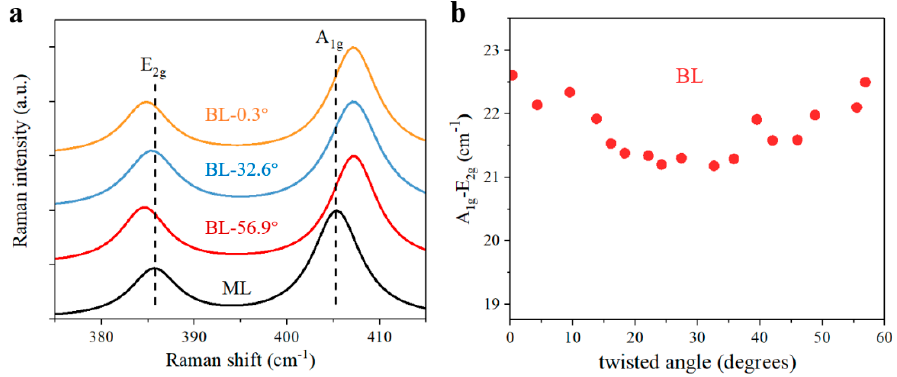
Figure 4. Raman spectra of twisted MoS 2 bilayers. ( a ) Raman signals of out-of-plane A 1 g and E 2 g in-plane vibration modes in prototypical monolayer and twisted bilayers. ML, monolayer. ( b ) Raman interval of A 1 g and E 2 g vibration modes. BL, normal